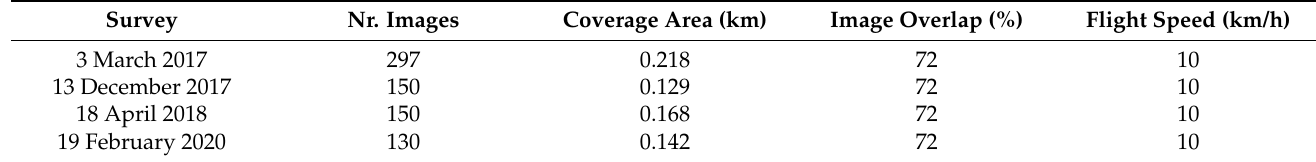
Table 1. Principal parameters of the four UAV survey